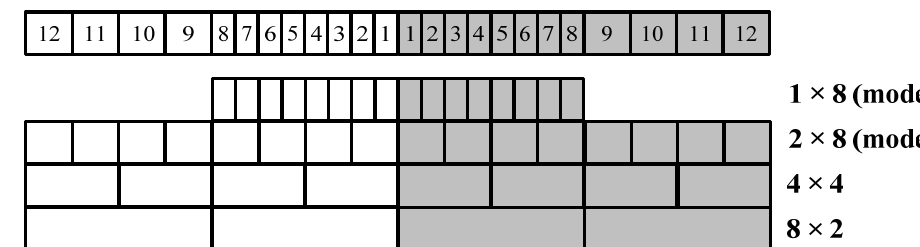
Figure 3. Detector unit readout